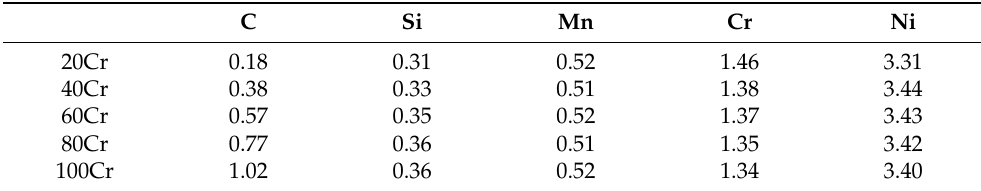
Table 1. The composition of the XXCr2Ni4Asteel